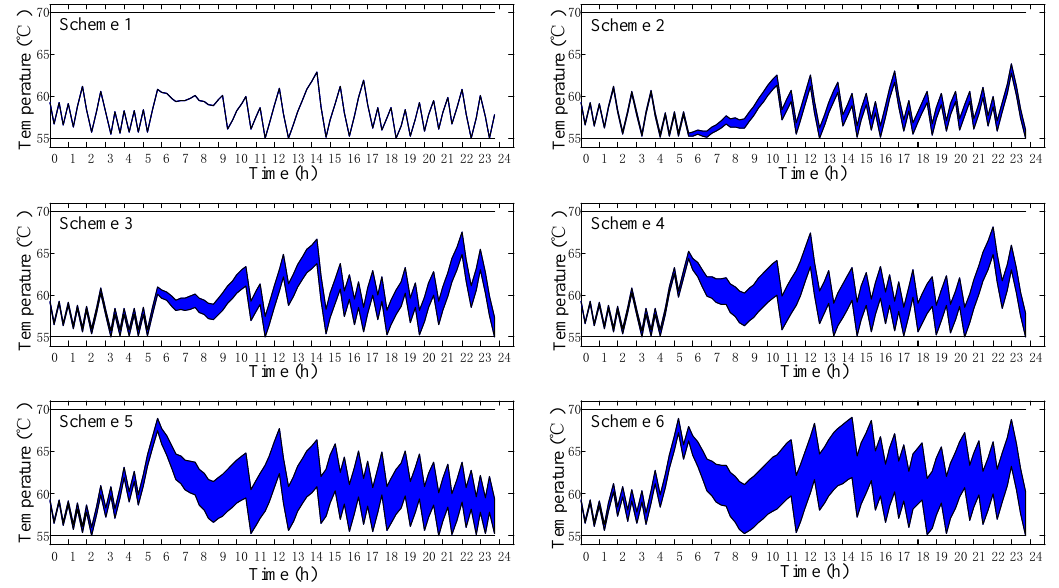
Figure 6. Hot water temperature under six typical robust schemes.